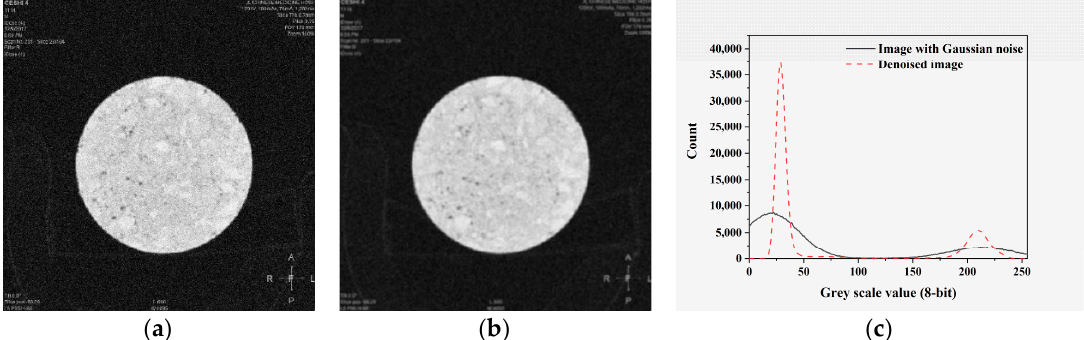
Figure 8. Process of image denoising: ( a ) scanning image with Gaussian noise; ( b ) denoised image; ( c ) gray level histogram.